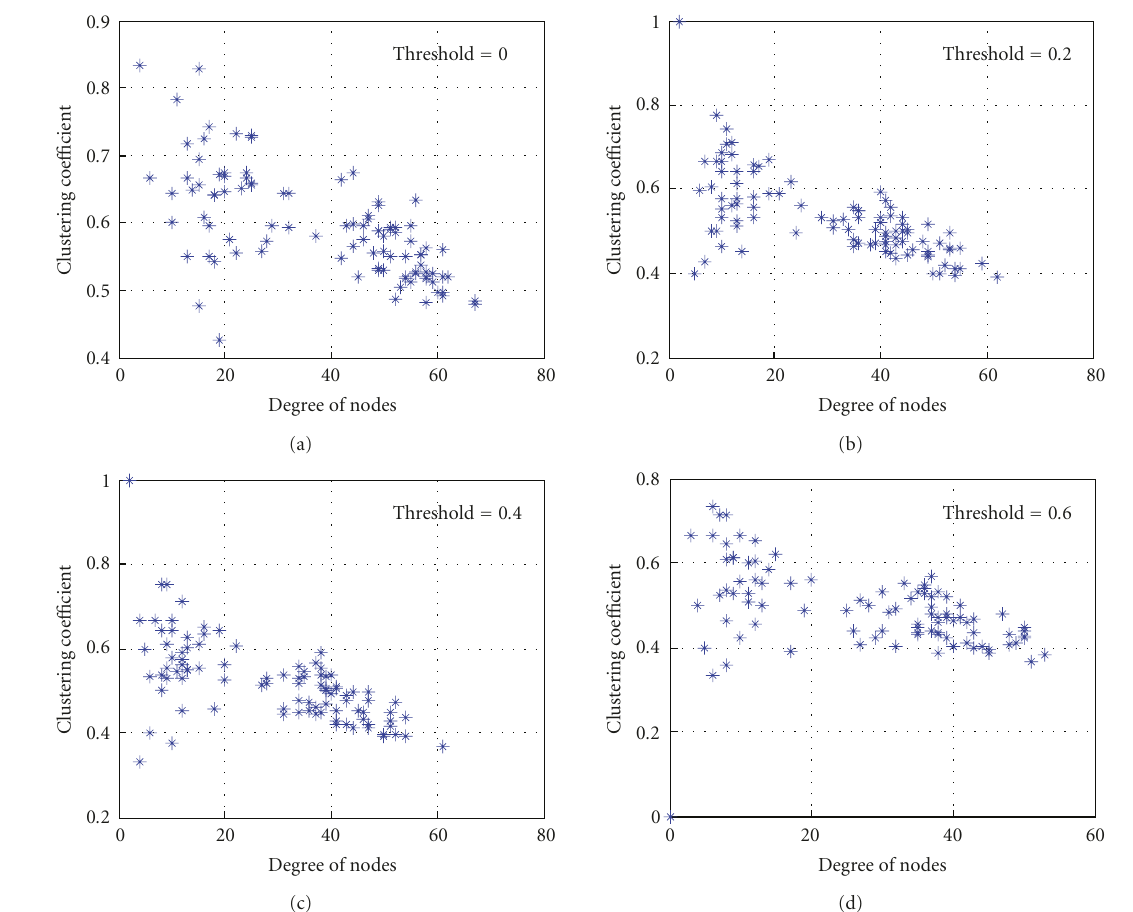
Figure 13: Variation of clustering coe ffi cient with degree of nodes: dataset A.